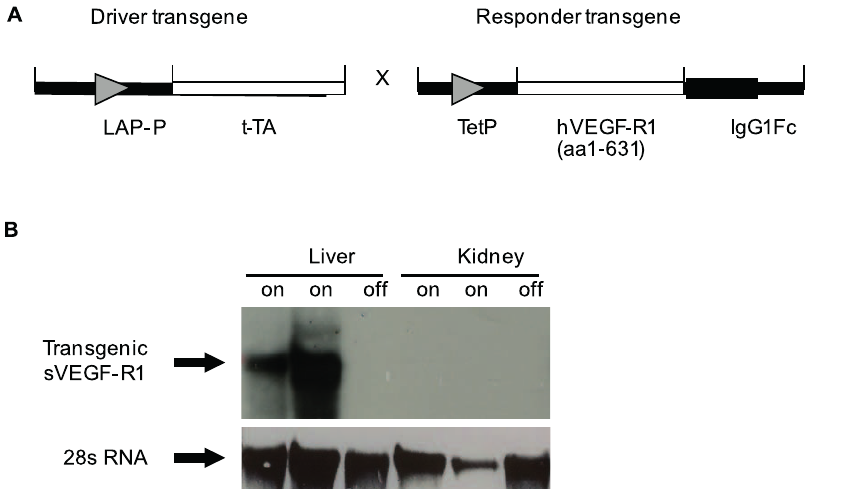
Figure 1. A bi-transgenic system for conditional and reversible suppression of VEGF signaling in the liver. (a) A schematic representation of the driver and responder transgenes used in the bi-transgenic system (b) Northern blot analysis of hepatic and renal RNA with a probe specific for transgenic (human) VEGF-R1. The term ‘‘off’’ indicates control littermates; ‘‘on’’ indicates that sVEGF-R1 expression was induced for 1 month in two transgenic animals. Note the tissue specific expression of the transgene.